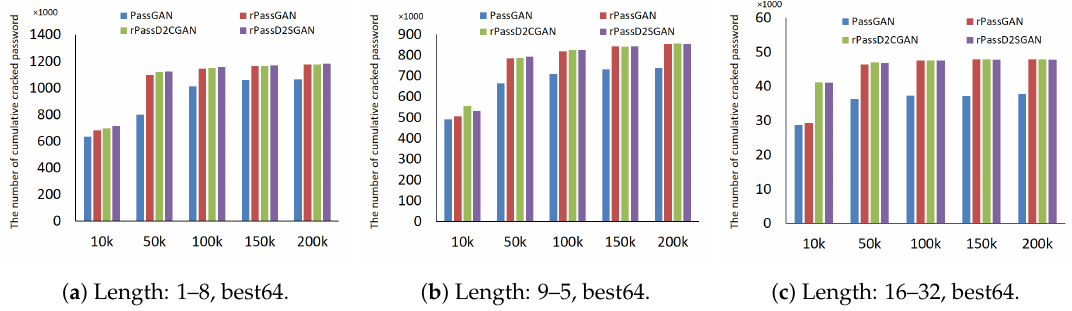
Figure 8. Total cumulative cracked passwords by training